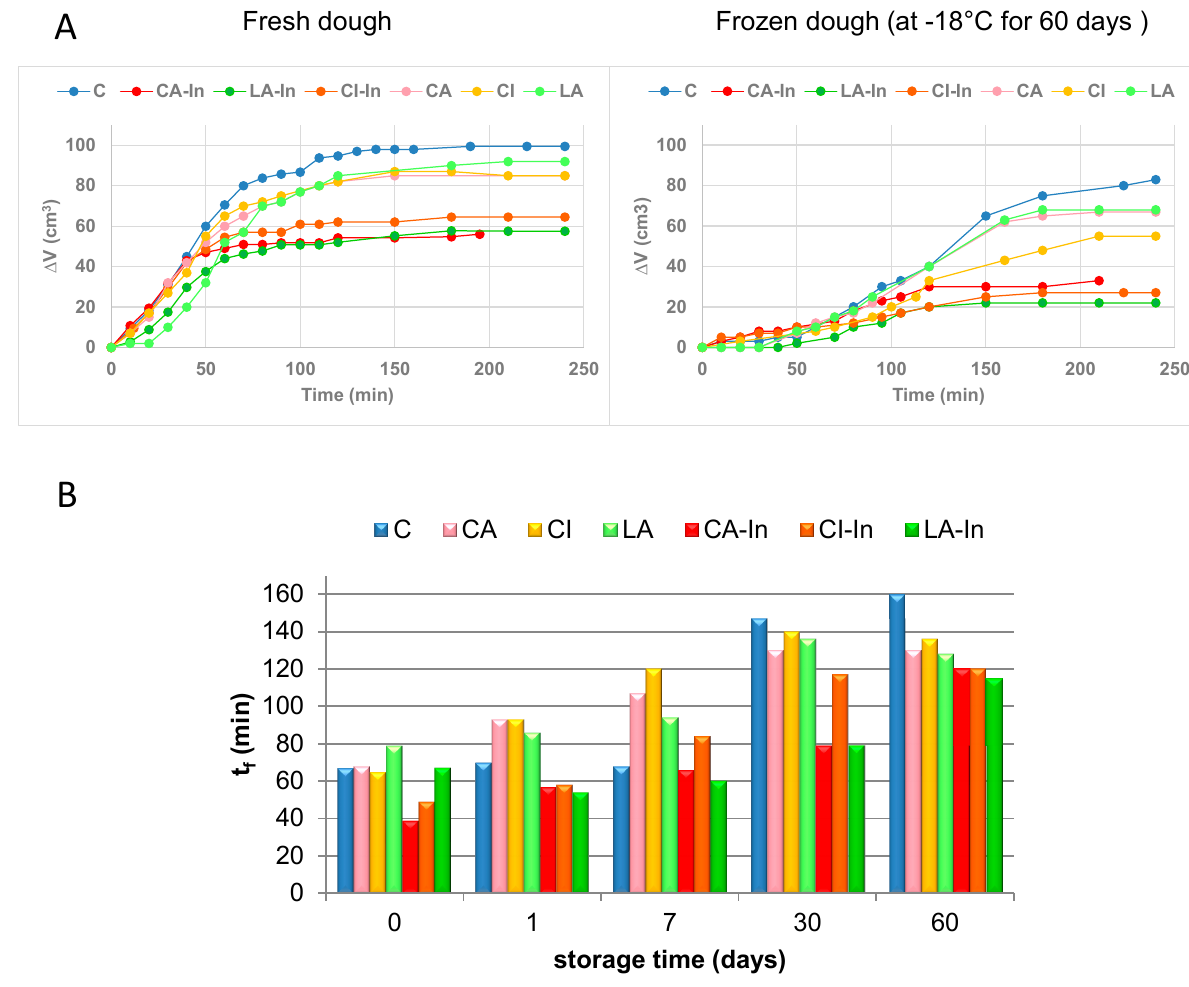
Figure 5. Fermentation of dough. ( A ). Fermentation curves obtained from fresh dough and frozen dough at − 18 °C for 60 days, ( B ) fermentation time of frozen dough at − 18 °C for 0, 1, 7, 30 and 60 days.